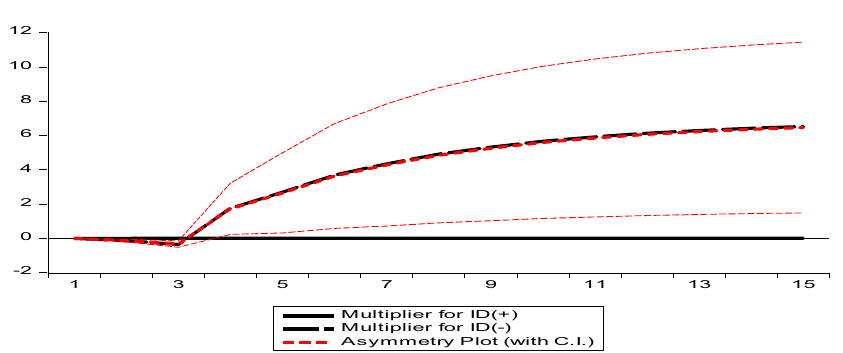
-.04-.02.00.02.04.06